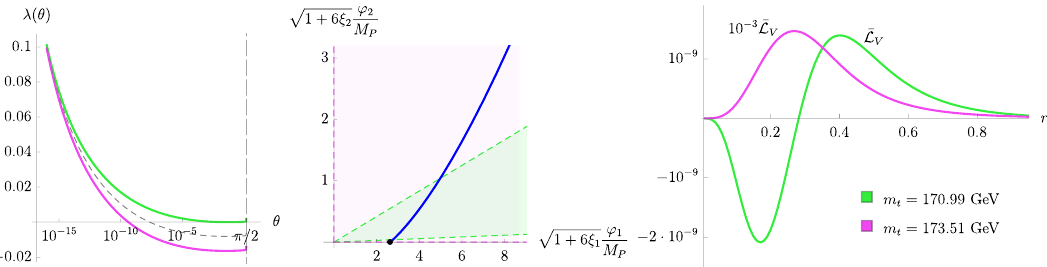
Figure 5 . Left: the SM Higgs self-coupling (cid:21) (^ (cid:22) ) at NNLO with the (cid:18) -dependent momentum scale ^ (cid:22) given in eq. (4.53). The RG equations are solved using the code based on [22, 73]. The solid lines represent the 2 (cid:27) -uncertainty region of the top quark mass, the dashed line corresponds to the central value m t = 172 : 25 GeV [74]. The Higgs mass is taken to be m H = 125 : 09 GeV [75]. Middle: the singular instanton in the potential (4.23) with (cid:21) plotted on the left side. The dashed lines encompass the regions of negative (cid:21) . One observes no di(cid:11)erence between the solutions corresponding to the di(cid:11)erent choices of (cid:21) . Right: the potential part of the instanton Lagrangian, see eq. (4.52).